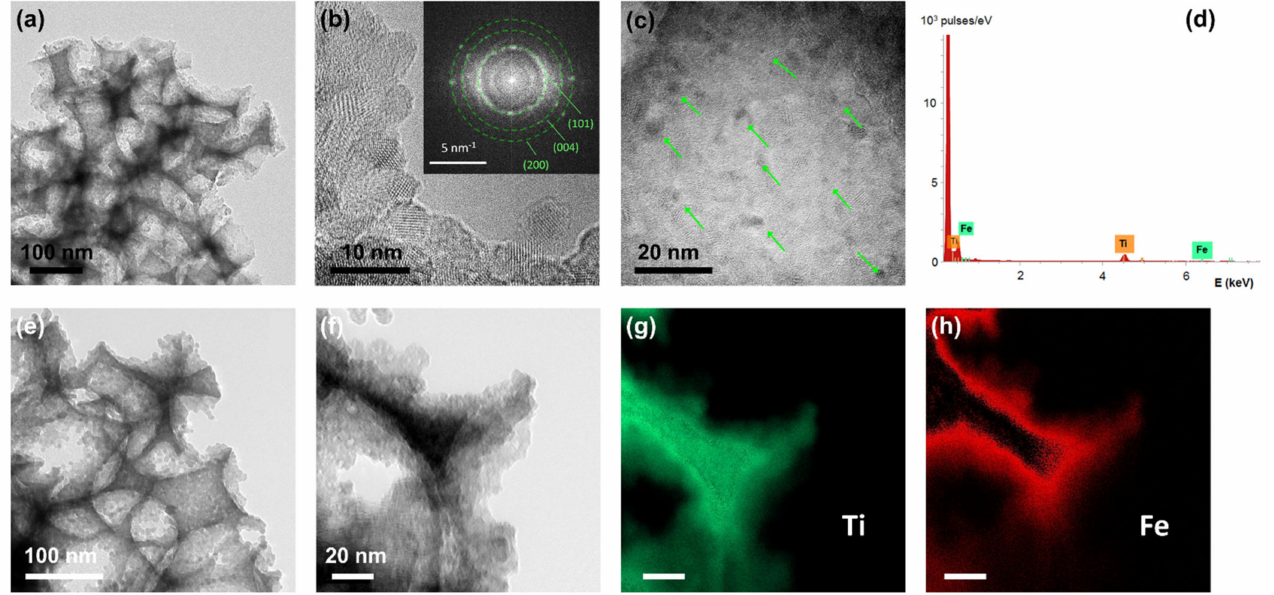
Figure 2. ( a – c ) TEM images for FeO x -PC260-1st at different magnifications. The inset in ( b ) shows the corresponding FFT pattern ( d ) Local EDX spectrum corresponding to the image ( b ). ( e , f ) TEM images for FeO x -PC260-3rd at different magnifications and the ( g ) Ti and ( h ) Fe EFTEM elemental maps corresponding to ( f